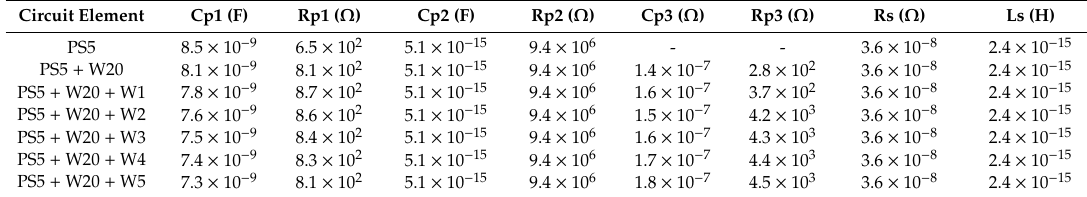
Table A5. Modeled impedance parameters Cp1, Rp1, Cp2, Rp2, Cp3, Rp3, Rs, and Ls of biochip PS5, with added DI water.